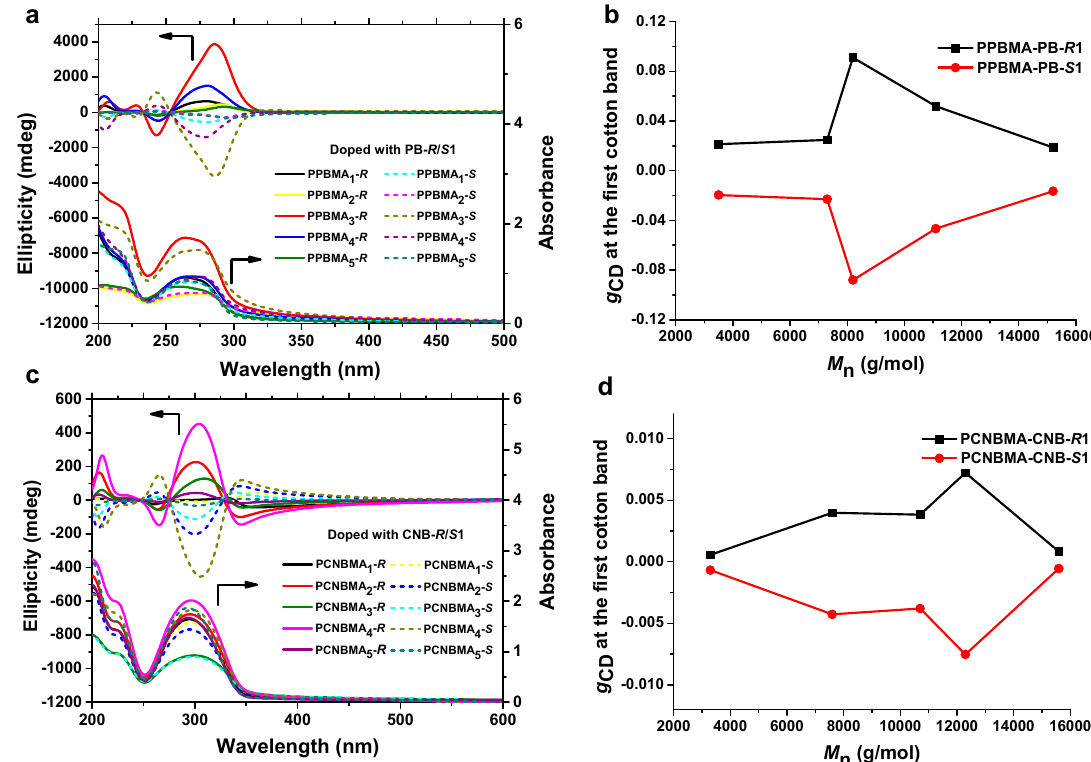
Figure 4. Changes in CD, UV-vis spectra and g CD values of polymer films prepared from the polymers with different molecular weights. ( a , b ) recorded from PPBMAs. ( c , d ) recorded from PCNB- MAs.